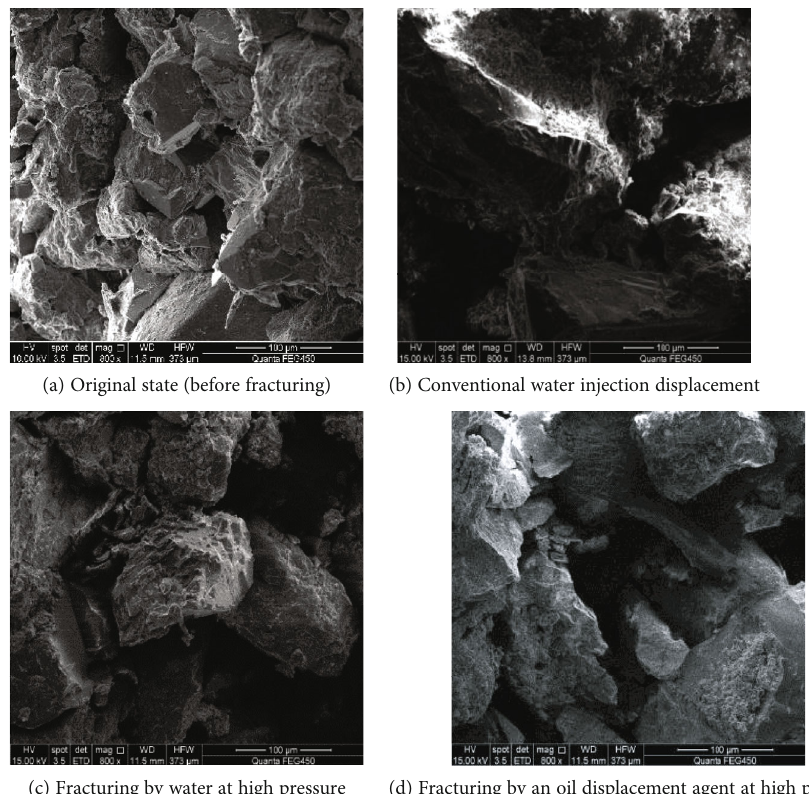
Figure 8: Changes of core pore structure in di ff erent states of core